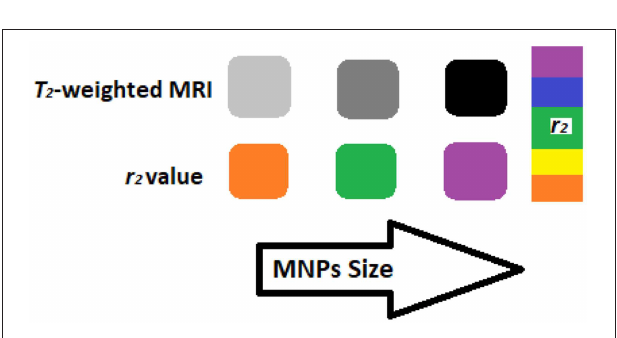
FIGURE 11 | T 2 -weighted contrasts and r 2 color maps for iron oxide nanoparticles of different sizes (Nanoparticles in magnetic resonance imaging: from simple to dual contrast agents) [adapted and modified from Estelrich et al. (2015) and Xu et al. (2016)].